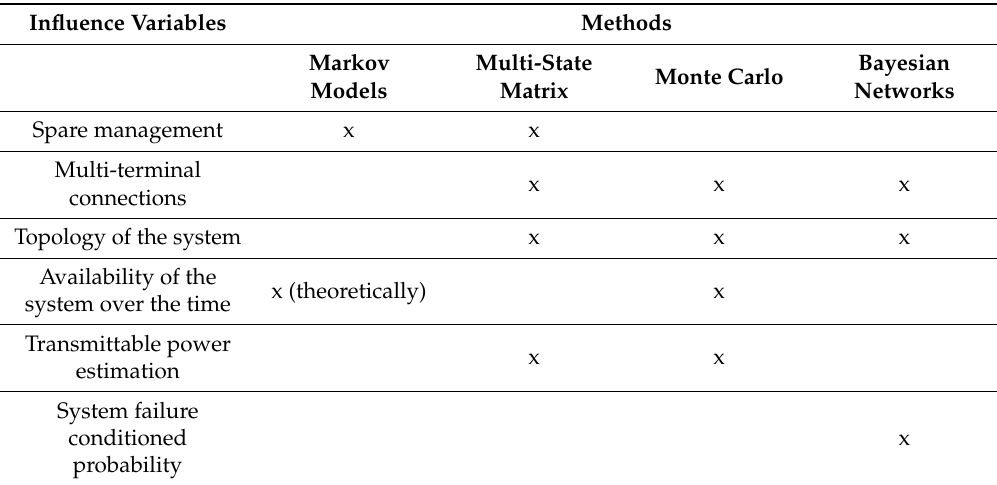
Table 2. Summary of the chief influence variables which each method is able to take into account in the availability